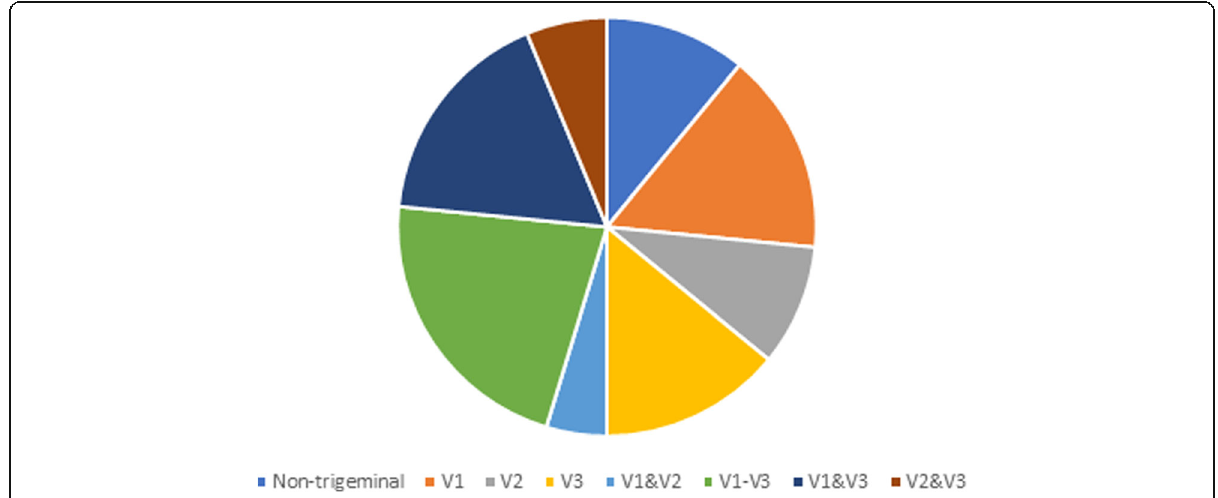
Fig. 3 Summary of pain locations in cohort 2